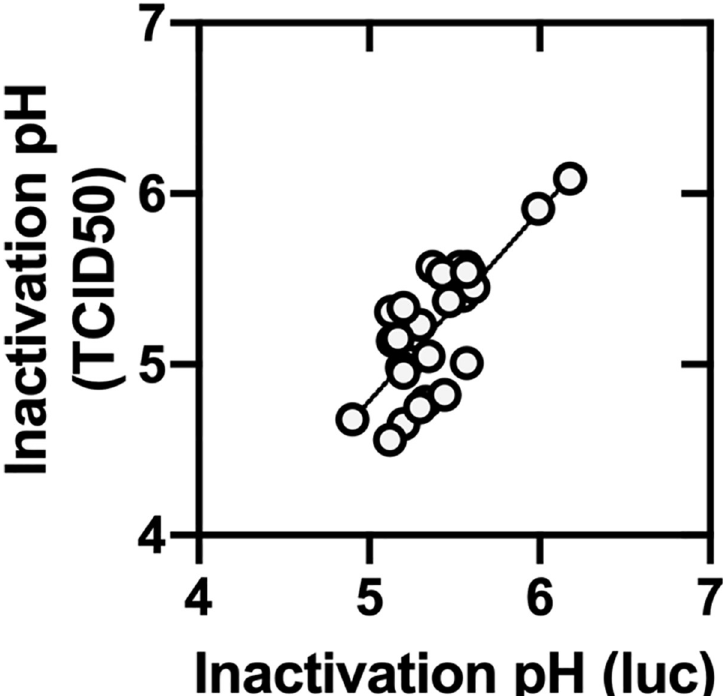
Fig 4. Comparison of virus inactivation values measured by TCID 50 and luciferase assays. Inactivation pH values measured byTCID 50 are reported as the calculated pH corresponding to a 2-log 10 (100-fold) drop in infectivity measured by TCID 50 assay. Inactivation pH values for luciferase assay are reported as the pH at the midpoint of the S- shaped luminescence curves. Both TCID 50 and luciferase inactivation values were calculated using GraphPad Prism 8 using a nonlinear regression with log(agonist) vs. response and a four-paramter variable slope. The displayed line (R 2 value of 0.604) was calculated by simple linear regression using GraphPad Prism